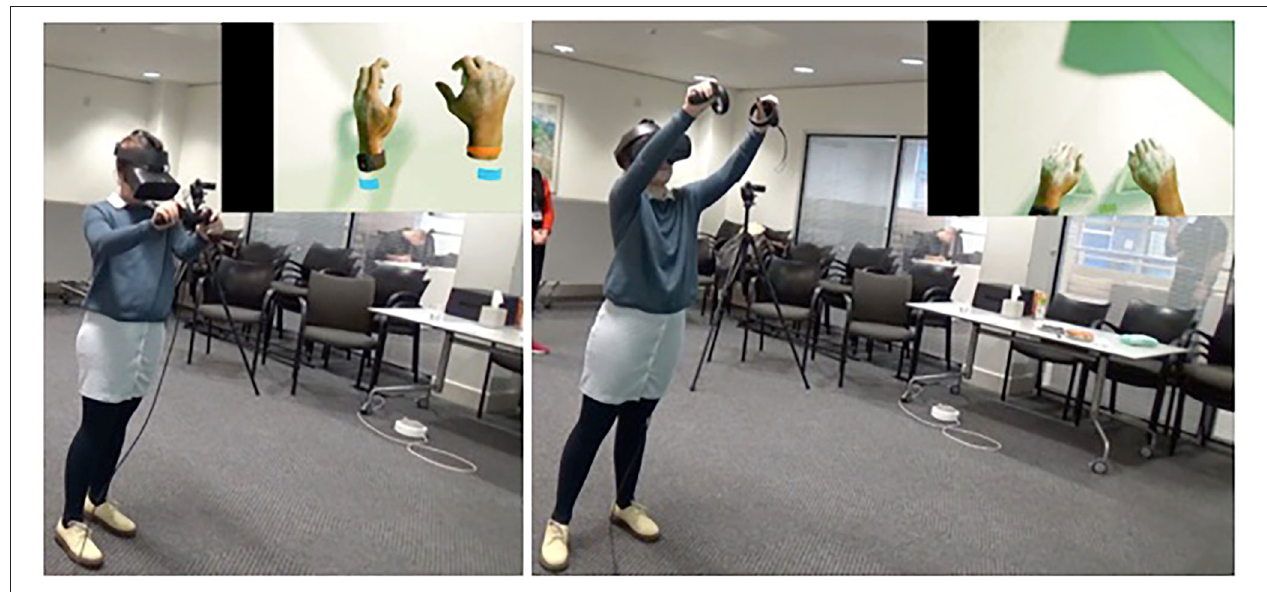
FIGURE 10 | Body positioning for low and high reaching in The Climb.